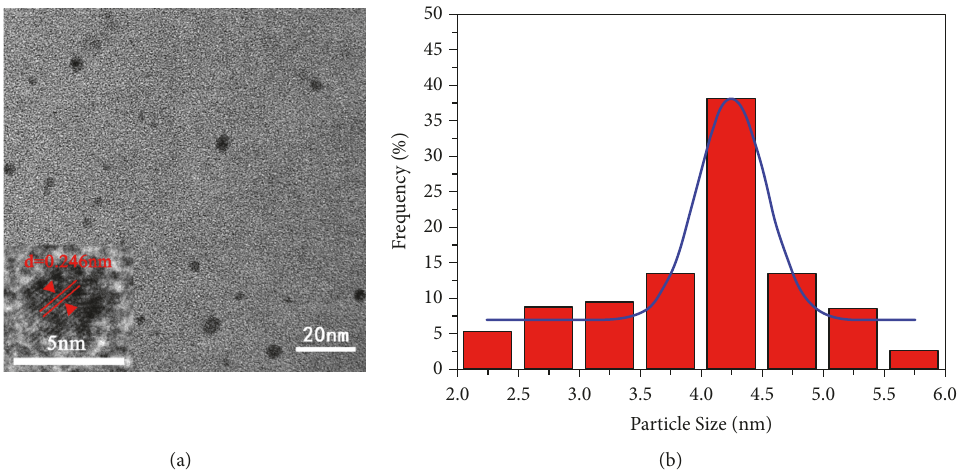
Figure 2: (a) TEM diagram of N-GQDs; (b) the size of distribution of the N-GQDs.